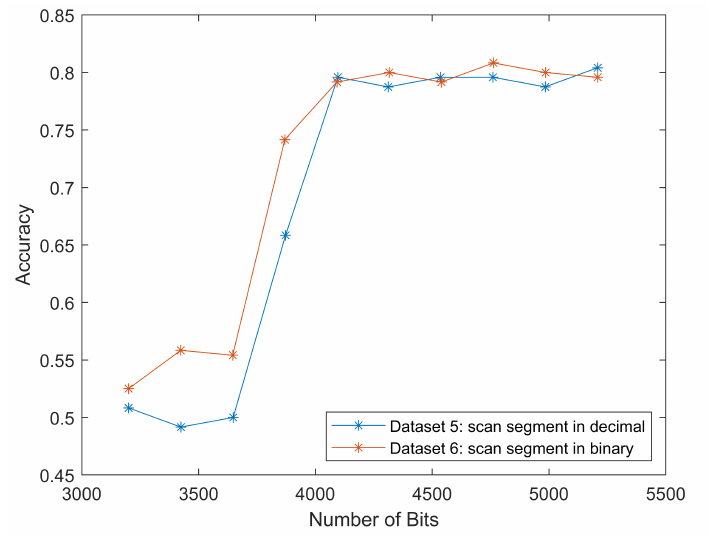
Figure 9. Classification accuracies for different lengths of scan segment in decimal or binary form. The sharp increase and good match of the two curves prove the scan segment can be classified in both decimal and binary